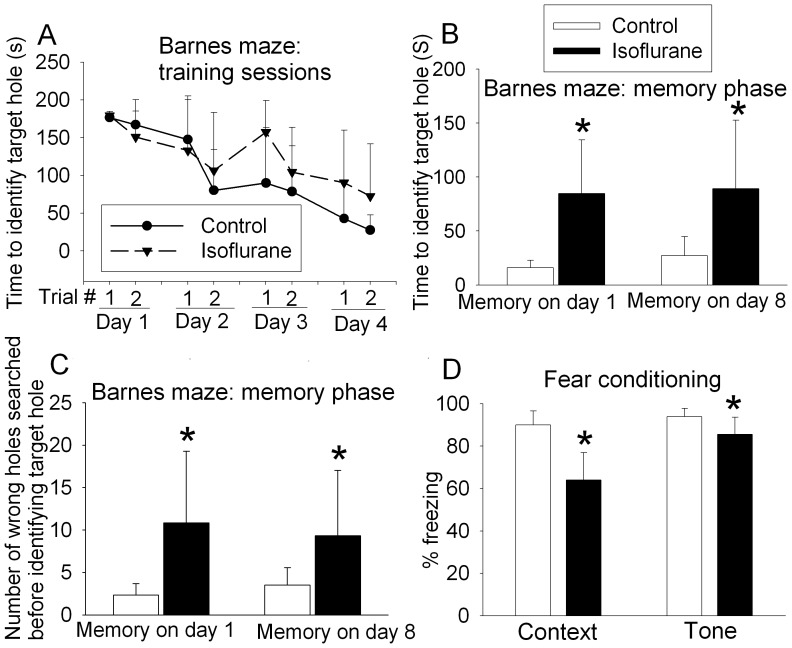
Isoflurane-induced cognitive impairment measured by Barnes maze and fear conditioning.Eighteen-month-old Fisher 344 rats were exposed to or were not exposed to 1.2% isoflurane for 2 h. They were subjected to Barnes maze 2 weeks later or fear conditioning 27 days later. A: performance in the training sessions of Barnes maze test. There is a significant effect of training sessions on the latency to identify the target hole (P<0.001 by two-way repeated measures analysis of variance). B: latency to identify the target hole at 1 day or 8 days after the training sessions. C: number of other hole searched before identifying the target hole at 1 day or 8 days after the training sessions. D: performance in fear conditioning test. Results are mean±S.D. (n = 6). *P<0.05 compared with the corresponding control in panels B, C and D by t-test.